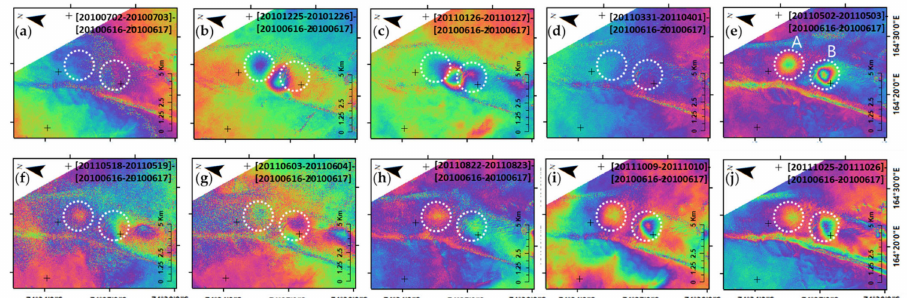
Figure 4. ( a – j ) A series of DDInSAR images of Campbell Glacier near the anomalies A and B. One color cycle represents 2 π phase. The dotted circles A and B were drawn based on ( e ) and their locations are identical at each image for comparison.